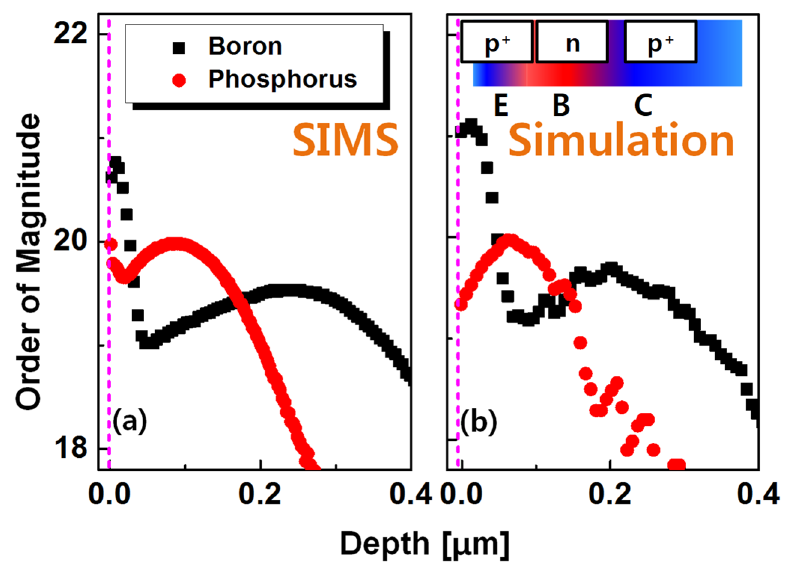
Figure 4. The asymmetric doping profile of the vertical Ge biristor from ( a ) measured SIMS data and ( b ) SILVACO simulation data.